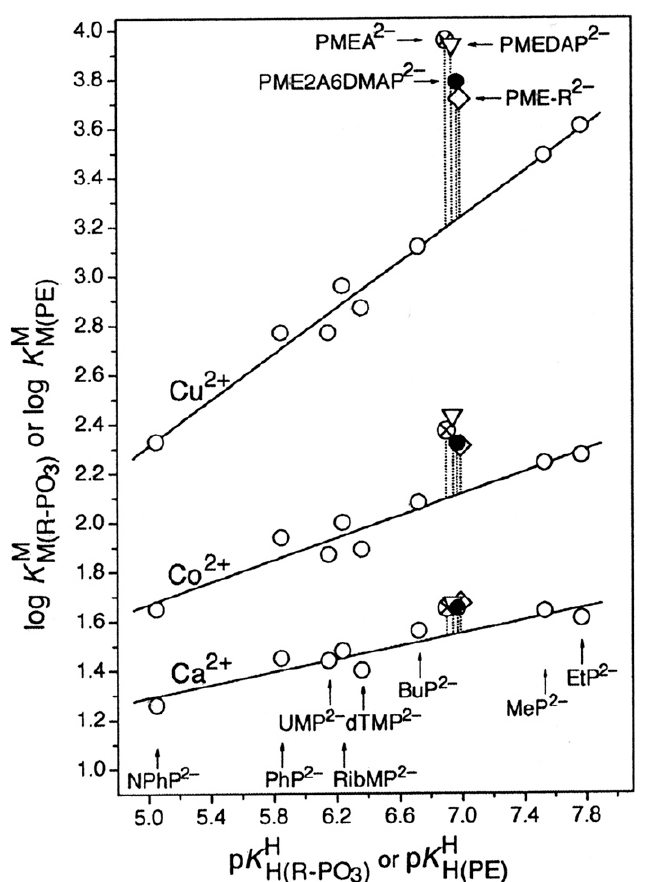
Figure 7. Evidence for enhanced stabilities of some M(PME2A6DMAP) ( • ) complexes in comparison with those of the corresponding M(PMEA) ( ⊗ , M(PMEDAP) ( ▽ ), and M(PME-R) ( ◇ ) species, based on the relationship between log K M and p K H for M(R-PO 3 ) complexes of some simple phosphate monoester and phosphonate ligands (R − PO 2– ) ( ) (see legend to Figure 4). The points due to the equilibrium constants for the M 2+ /PME2A6DMAP systems ( • ) are based on the values listed in Tables 1 and 2 of Ref [61]; those for the M 2+ /PMEA systems ( ⊗ ) are from Ref [44], for the M 2+ /PMEDAP systems ( (cid:53) ) from Ref [62], and those for the M 2+ /PME-R systems ( ) are based on p K H = 6.99 ± 0.04 (average of the p K a values for H(PME) − (7.02) and H(PMEC) − (6.95) [63]) and the stability enhancements listed in Ref [63]. The vertical broken lines emphasize the stability differences to the reference lines; they equal log ∆ M/PE , as defined in Equation (12) for the M(PE) complexes in general. All the plotted equilibrium constants refer to aqueous solutions at 25 ◦ C and I = 0.1 M (NaNO 3 ). Reproduced with permission from our publication in the Canadian Journal of Chemistry [61]; copyright 2014, NRC Research